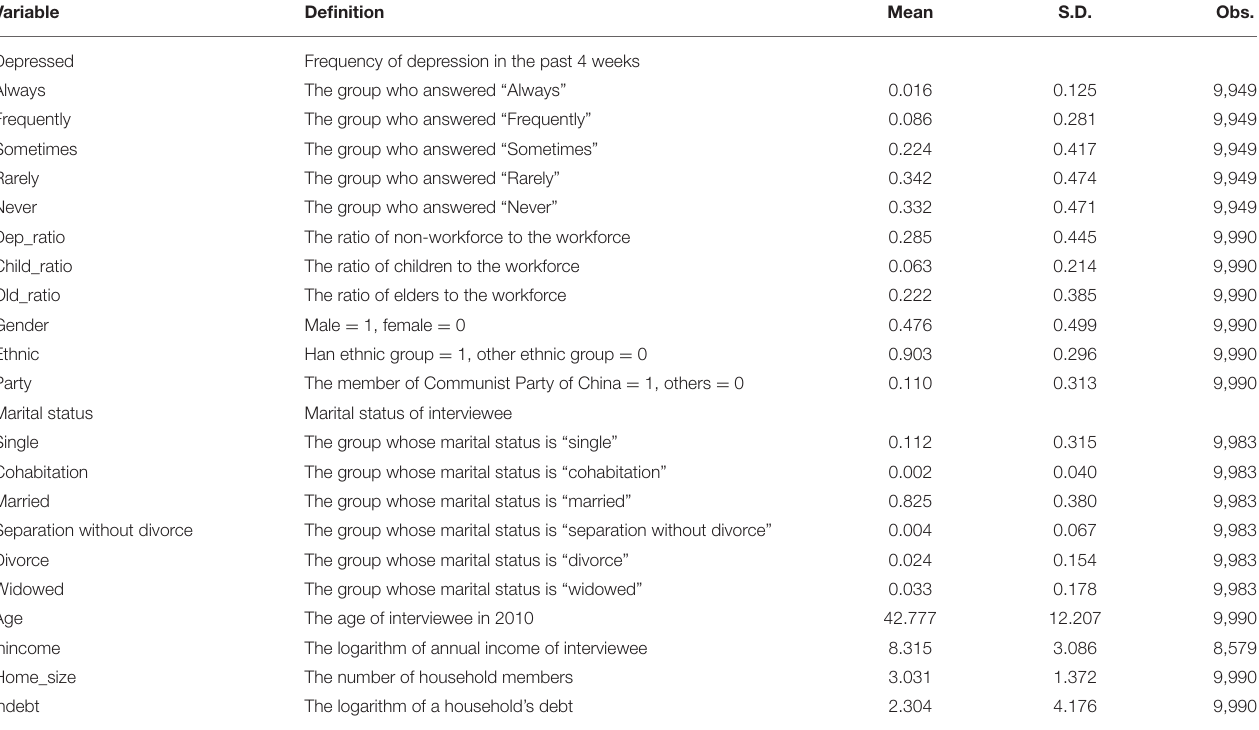
TABLE 1 | Summary